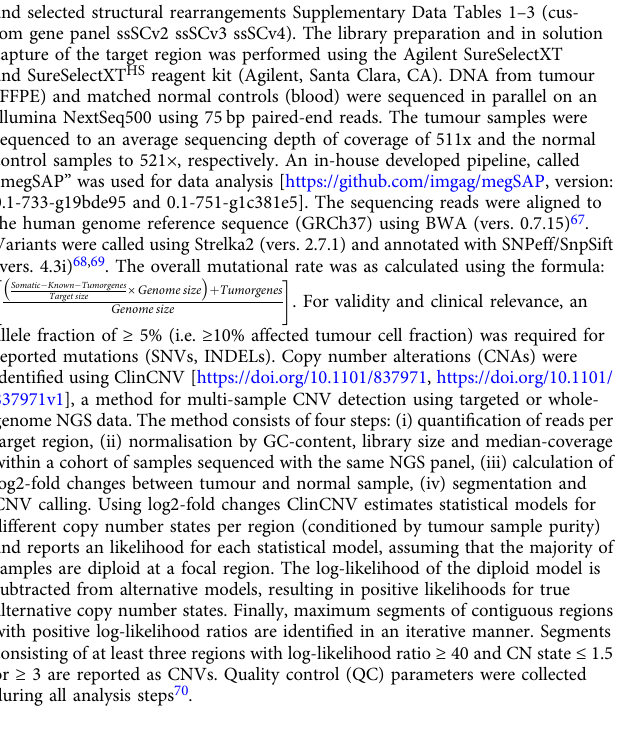
Fig. 10 Loss of senescence-inducing and ampli fi cation of senescence-inhibiting cell cycle regulator genes in melanoma metastases of patients resistant to ICB. a – c Sequencing data from metastases of non-responder patients ( N = 30) versus metastases of responder patients ( N = 12). In non- responder patients disease progressed within 3 months of ICB therapy. In responder patients metastases regressed ≥ 1 year of ICB therapy. Tumour mutational burden (TMB, copy number variations) ( a ). Number of tumour-speci fi c alterations in 19 genes of the cell cycle, JAK or MYC pathway ( b ). Number of genes with homozygous deletions in cycle inhibitors or ampli fi cations ≥ 3fold in cell cycle promoters. Genes analysed: